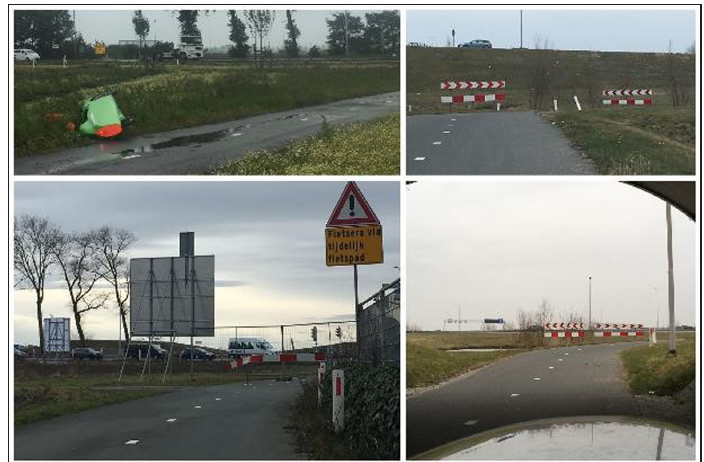
Figure 5: Collage of detrimental situation 2019–2021.